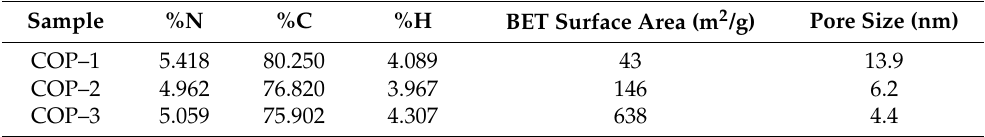
Figure 1. Simplified molecular structure of the three: COP–1, COP–2, and COP–3. Combustion chemical analysis determines the percentage of carbon, hydrogen, and nitrogen of each of the three COPs. The corresponding values are provided in Table 1. The nitrogen percentage measured with this technique corresponds to the nitrogen present in the Porph-Br 4 macro-rings and it is used to calculate the porphyrin content of the COPs. Moreover, the carbon percentage is used to calculate the cross-linker content for each COP. The analytical data with respect to the porphyrin/cross-linker molar ratio are included in Table S1. Considering that each boronated functional group of the cross-linker component reacts with each bromine atom of the porphyrin, the molar ratios of porphyrin/cross-linker should be 1:2, 1:1, and 1:1 for COP–1, COP–2, and COP–3, respectively. In the case of COP–2 and COP–3, the molar ratios match well with the expected stoichiome ‐ try used during synthesis; however, the molar ratio in the case of COP–1 is 1:1.8, which differs from 1:2, meaning that the porphyrin content is higher than expected. Table 1. Nitrogen, carbon, and hydrogen percentages obtained from the combustion chemical analysis cific surface area and porosity. A summary of the results is also included in Table 1. It can of COP–1, COP–2, and COP–3. Surface area and pore size for the three COPs estimated by isothermal N 2 adsorption are